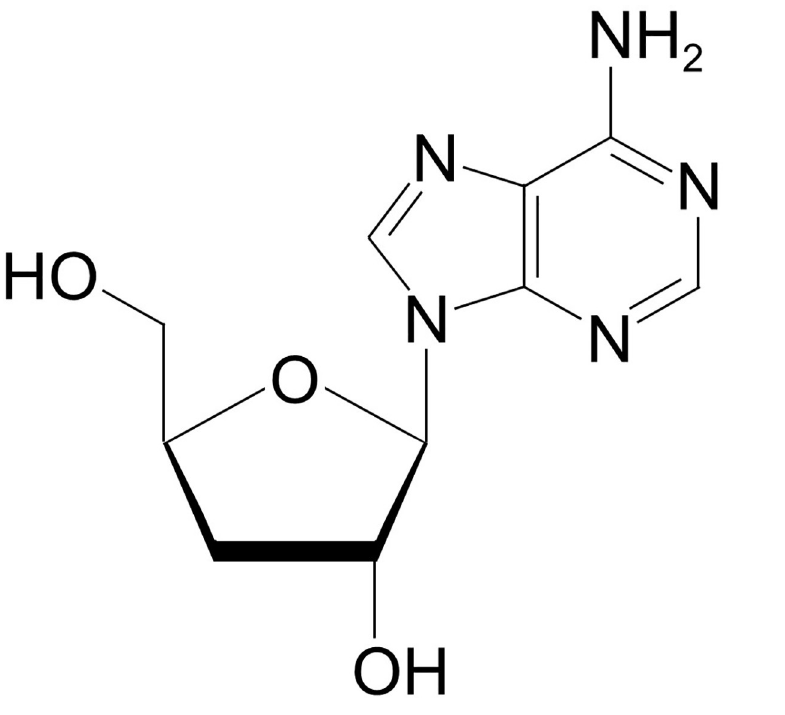
Fig 1. Chemical structure of